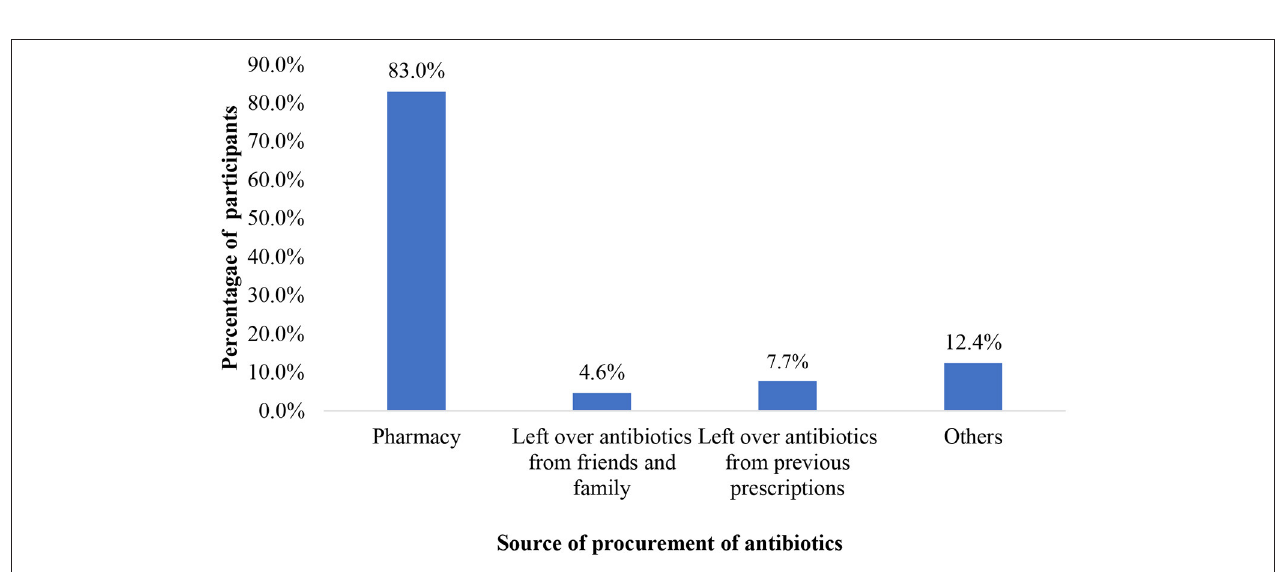
FIGURE 2 | Reasons cited for self-medication among respondents.